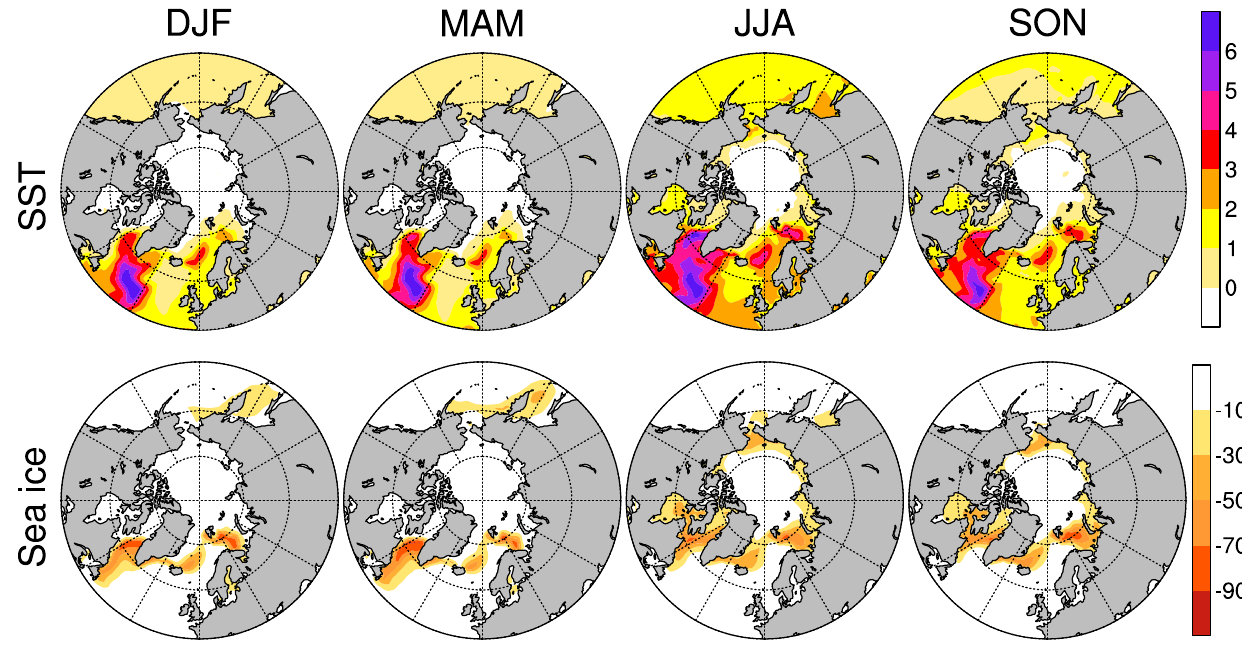
Figure 2. Seasonal mean (top) SST (K) and (bottom) sea ice concentration anomalies (%) in Eemian relative to PI (preindustrial period) boundary